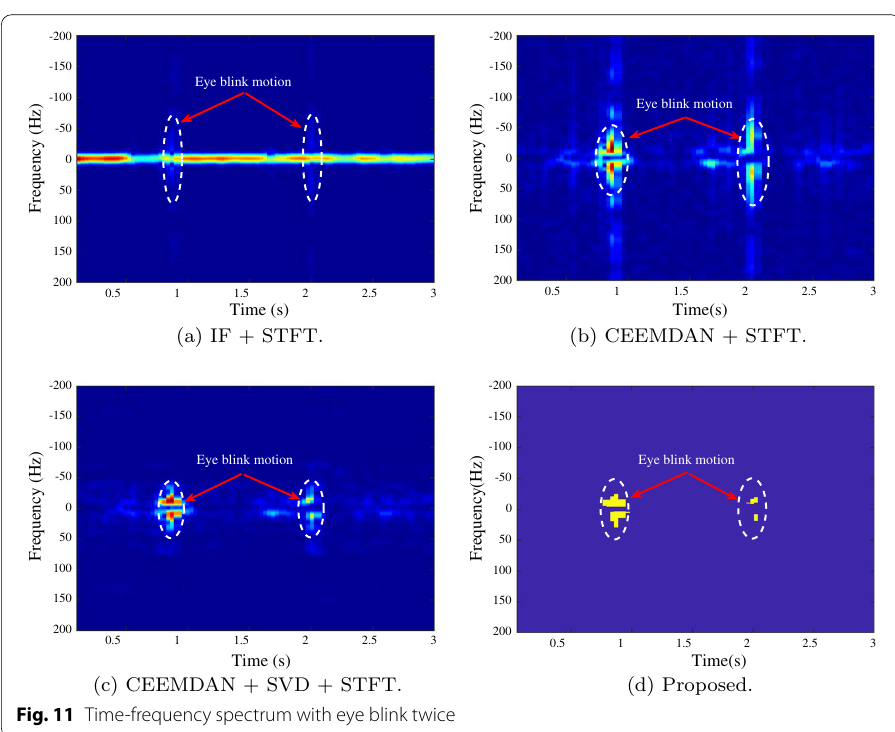
Fig. 11 Time-frequency spectrum with eye blink